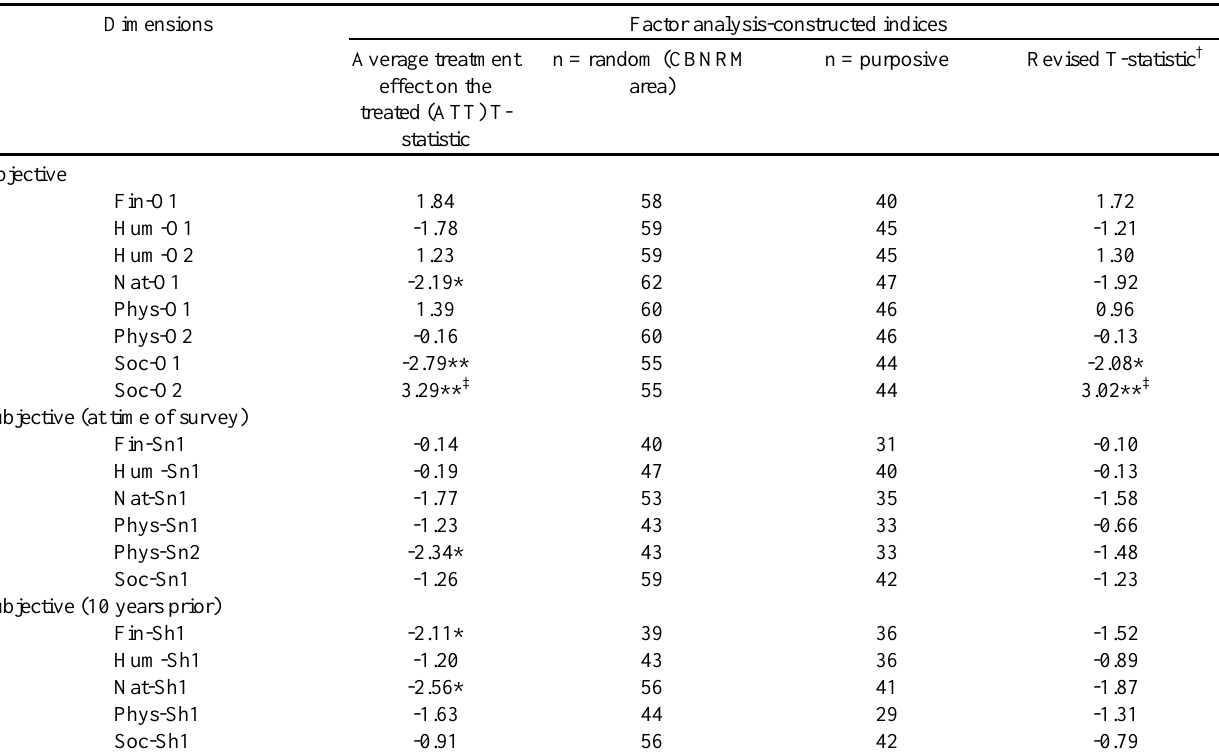
Table 5 . Tchuma Tchato: impact of project activities on poverty dimensions, purposive and random group (within community based natural resource management [CBNRM] area). Dimensions Factor analysis-constructed indices Average treatment n = random (CBNRM n = purposive Revised T-statistic † effect on the area) treated (ATT) T- statistic Objective